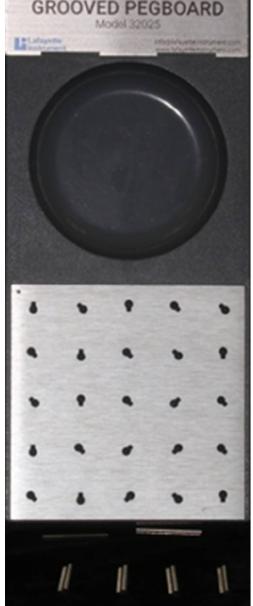
Figure 1. The Grooved Pegboard test device.